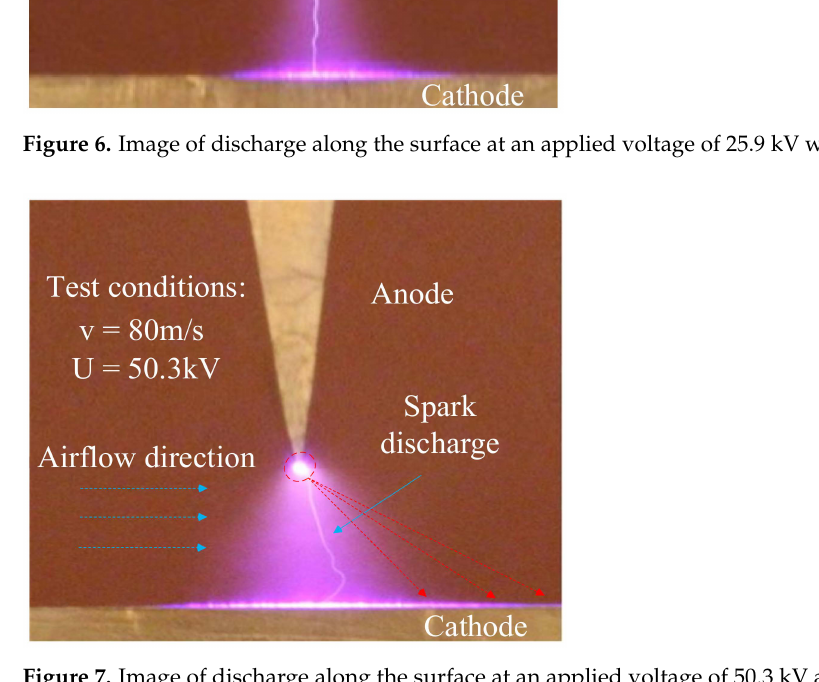
Figure 7. Image of discharge along the surface at an applied voltage of 50.3 kV at an airflow speed of 80